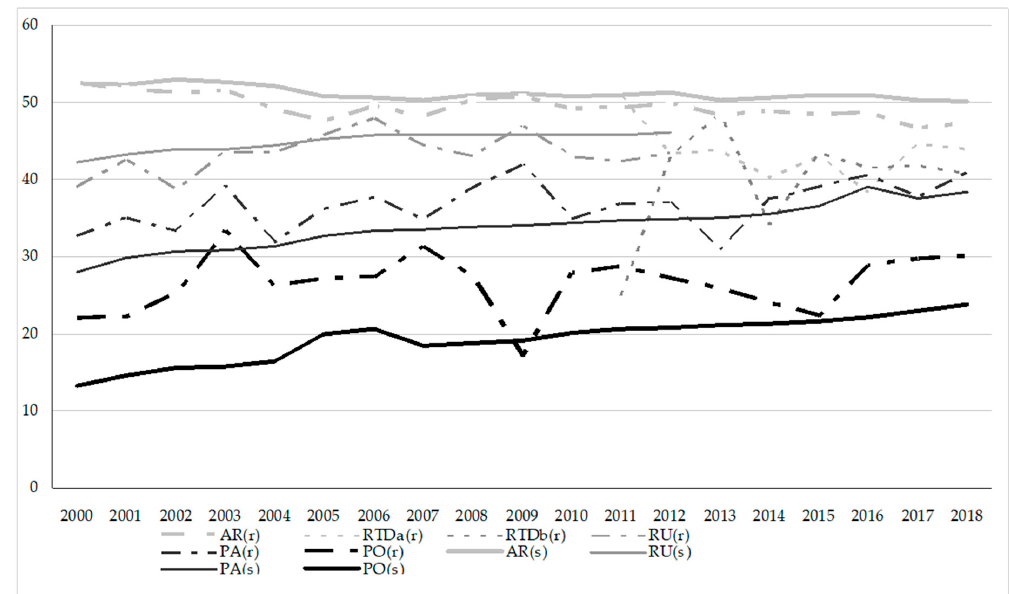
Figure 2. Female % by year and rank, 2000–2018, Italy: stock vs. recruited. Note: AR: (assegnisti di